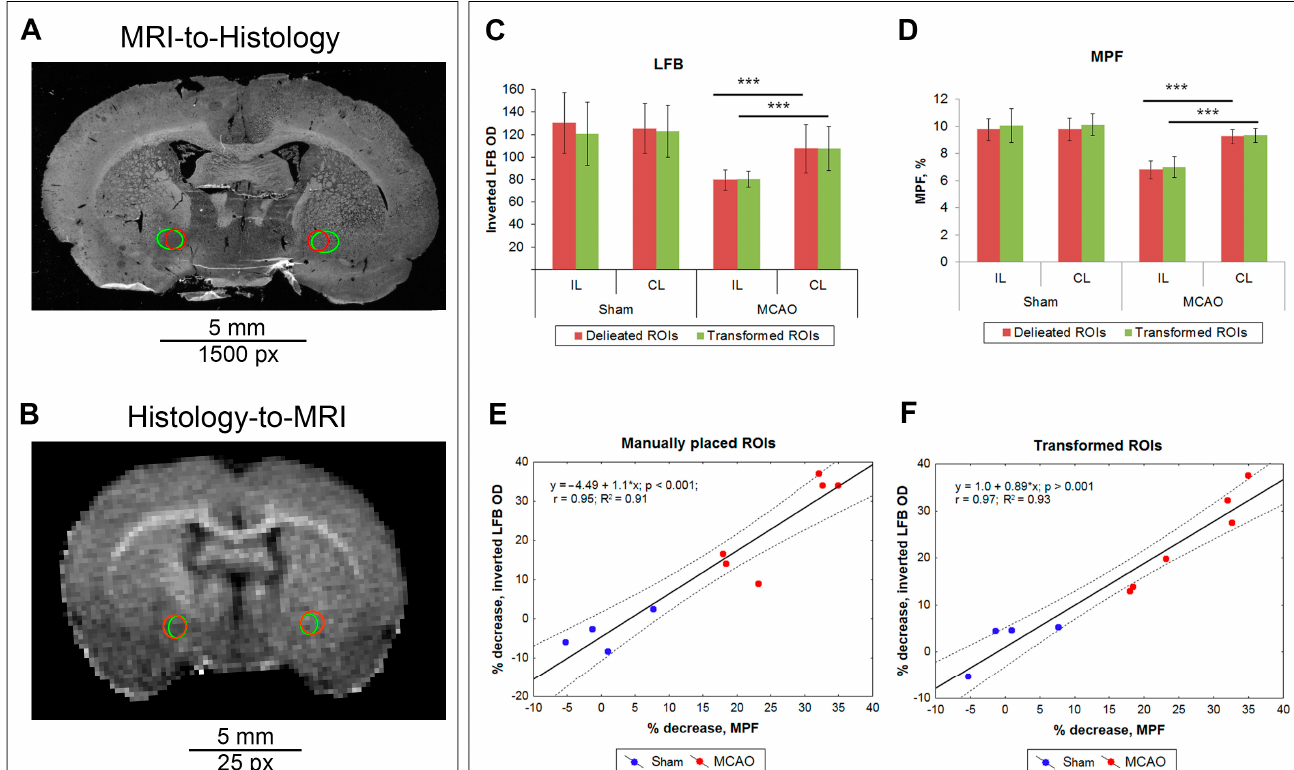
Figure 6. Correspondence of LFB OD and MPF measurements performed by the ROIT method and manual ROI placement on LFB-stained images and MPF maps in MCAO and sham-operated rats. ( A , B ) Example of the inverted red channel of the LFB image ( A ) and MPF map ( B ) of MCAO animal with ROIs into the ischemic lesion (IL) and contralateral side (CL). Manually placed round ROIs are marked by the red color; transformed ROIs are marked by the green color. ( C , D ) MPF ( D ) and LFB OD ( C ) measurements in the ischemic lesion (same size ROI in caudoputamen in sham-operated animals) and anatomically matched contralateral hemisphere. Error bars correspond to standard deviations. Significant differences: *** p < 0.001. ( E , F ) Linear regression plots of percentage changes in LFB OD, which were measured in manually placed ( E ) or transformed ROIs in the ischemic lesion relative to the symmetric contralateral anatomical region as a function of percentage changes in MPF.